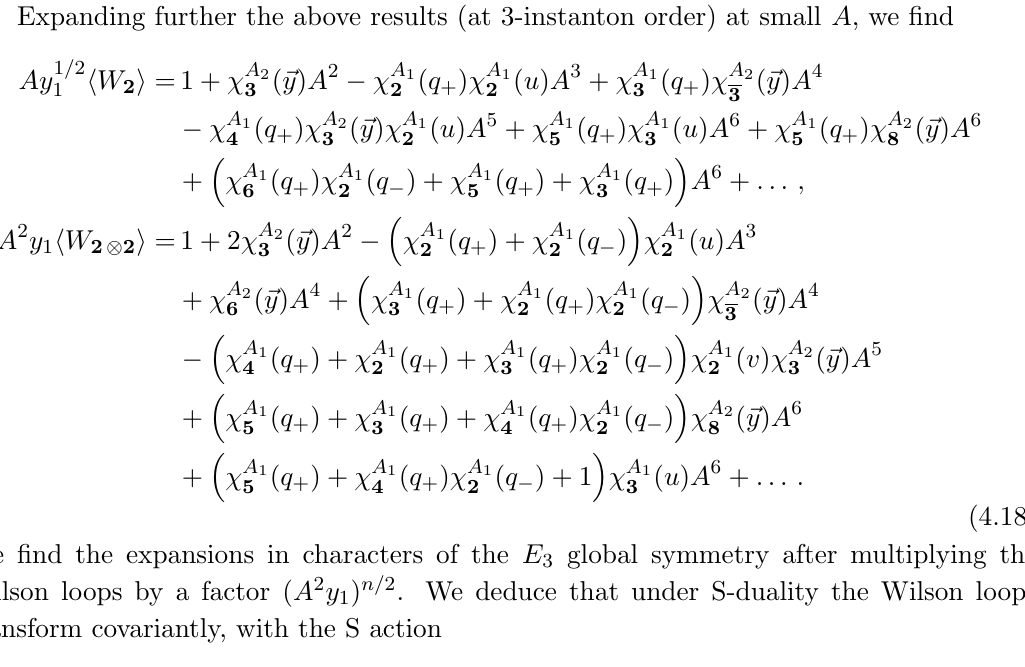
. The (cid:13)avor symmetry transformation